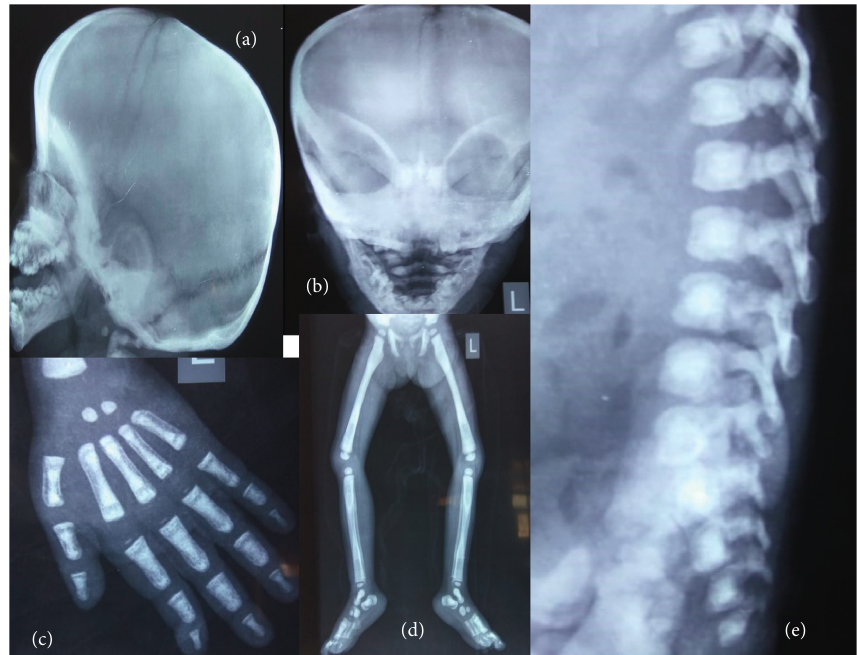
Figure 2: (a) & (b) X-rays in case 4: Skull lateral and AP view showing calvarian and basilar thickening, poorly developed sinuses and sclerosis of nasal bone; (c) X-ray hand showing bone in bone appearance; (d) X-ray lower limbs showing bone in bone appearance and increased bone density; (e) X-ray spine lateral view showing bone in bone appearance; (f) X-ray chest showing increased bone density in ribs and absence of corticomedullary differentiation.